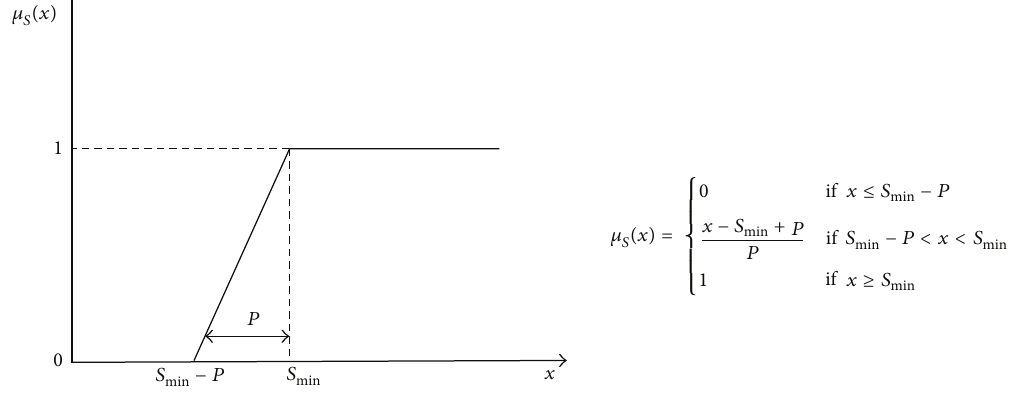
Figure 1: Membership function for total collected score of a path.